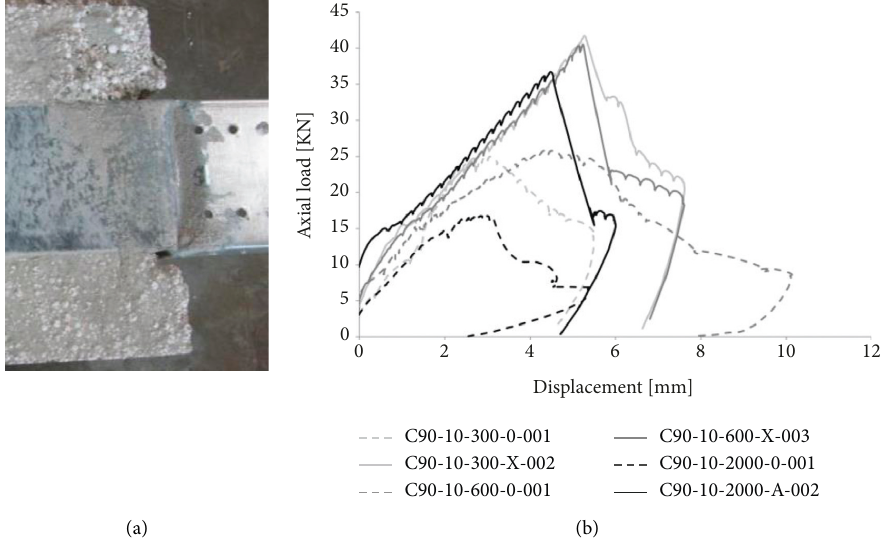
Figure 4: Failure of encased specimens (a) and axial load-displacement curves (b)